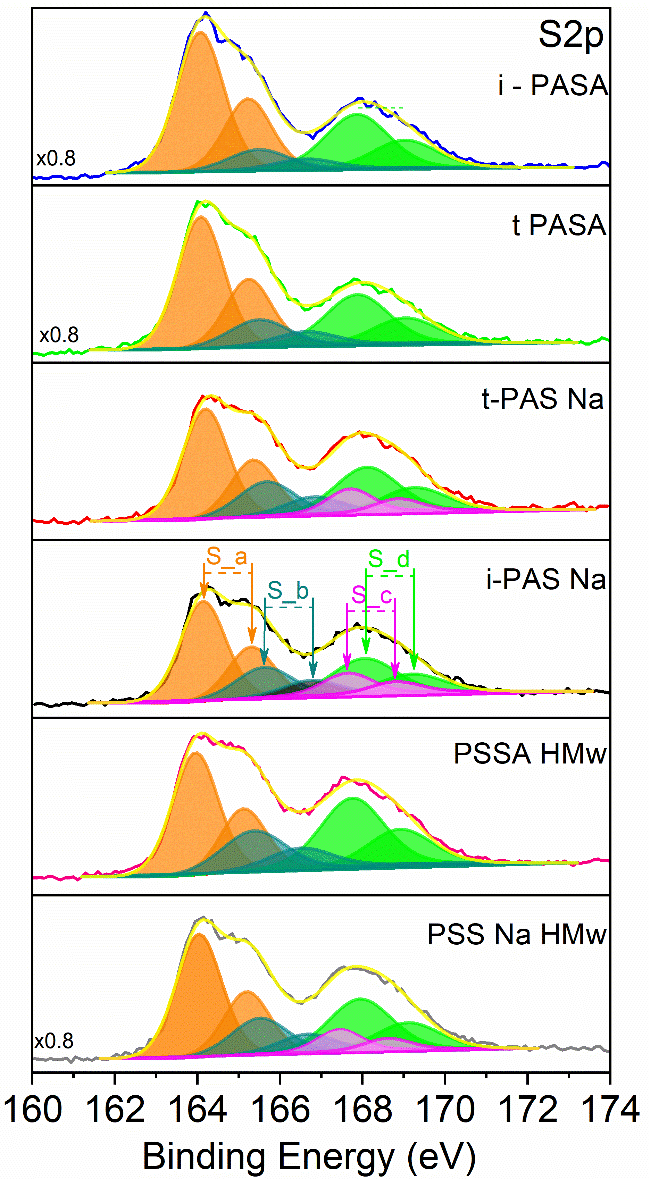
Figure 3. Deconvoluted S (2p) spectra of the different PEDOT materials. Table 2. Binding energies in eV of the sulfur species in different chemical environments available in the PEDOT/polysulfonates.